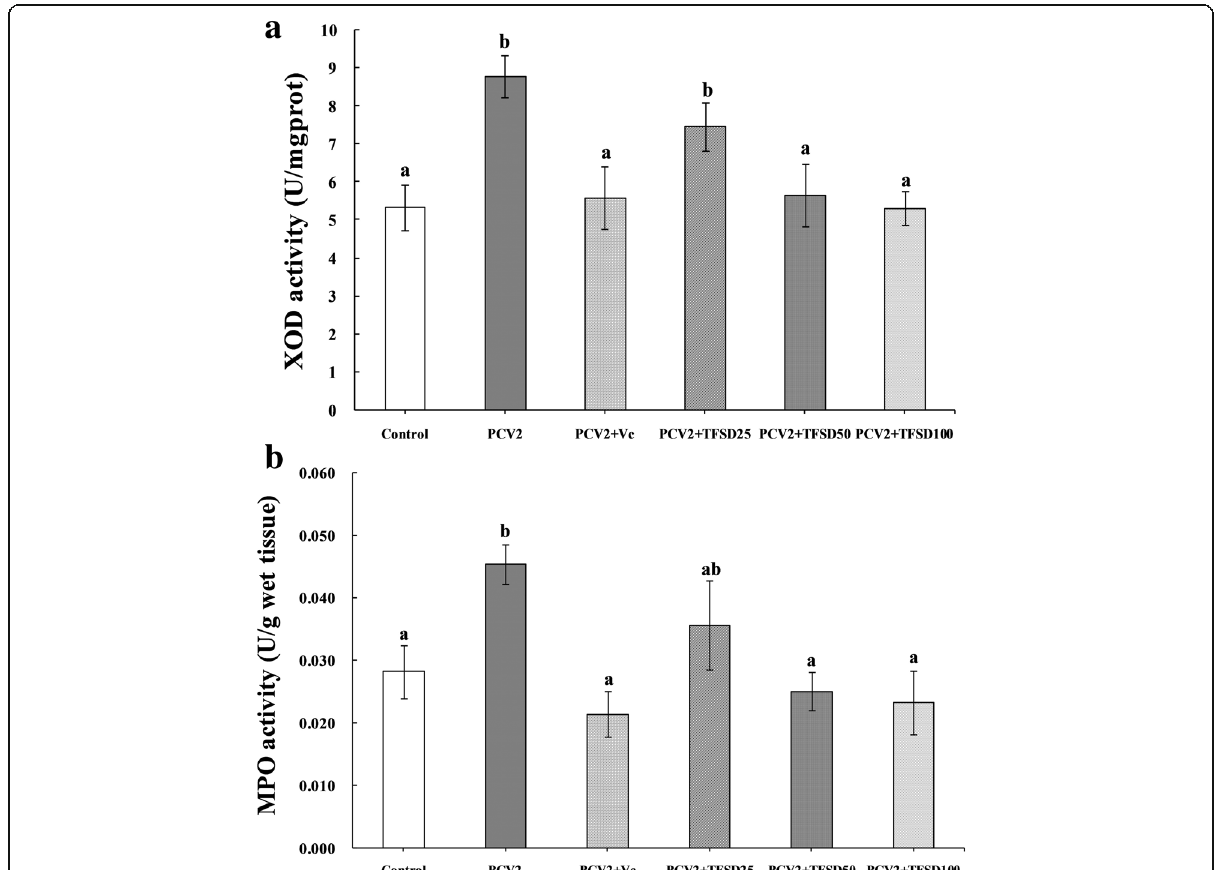
Fig. 5 Effect of TFSD on activities of XOD ( a ) and MPO ( b ) in PCV2 infected RAW264.7 cells. Data are presented as mean ± S.D. Bars with different letters are statistically different ( P < 0.05). Control: cells without PCV2 infection and drug treatment; PCV2: cells infected with 10 2.7 TCID 50 PCV2; PCV2 + Vc: cells treated with 100 μ g/mL of vitamin C after PCV2 infection; PCV2 + TFSD25 – 100: cells treated with TFSD at concentrations of 25, 50 or 100 μ g/mL after PCV2 infection,